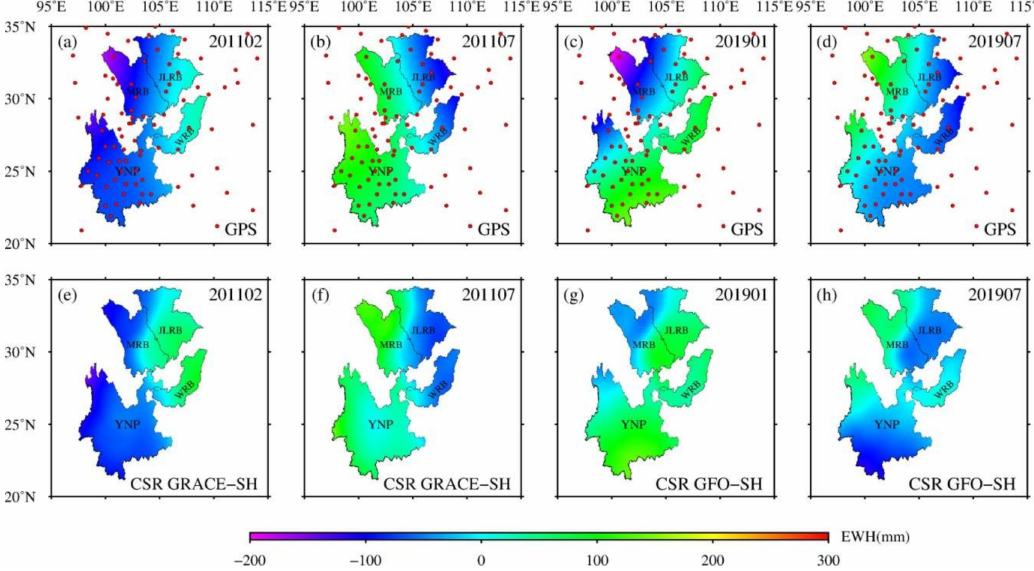
Figure 6. Surface mass variations derived from GPS vertical displacements and CSR RL06 GRACE / GFO Spherical Harmonic (SH) solutions in February and July 2011, and January and July 2019, respectively. ( a – d ) show the spatial distributions inverted by GPS in February and July 2011, and January and July 2019, respectively, and the red dots represent the location of GPS stations; ( e , f ) show the spatial distributions inferred from CSR RL06 GRACE SH solutions (CSR GRACE-SH) in February and July 2011, respectively; ( g , h ) show the spatial distributions inferred from CSR RL06 GFO SH solutions (CSR GFO-SH) in January and July 2019, respectively.